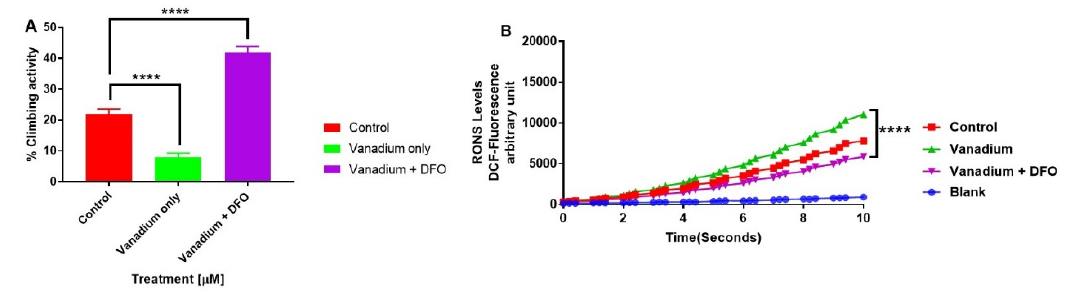
Figure 5. The influence of iron chelation following a chronic exposure of Drosophila melanogaster (PINK-1 mutant) to low-dose vanadium upon motor activity ( A ) and reactive oxygen species (ROS) production in fly brains ( B ) on day 14. Exposure of PINK-1 mutant to vanadium exacerbated the existing locomotor deficits in PINK-1 flies (**** p < 0.0001), comparing the slope of vanadium versus the control. However, a significant improvement was observed in the motor activity in the presence of the iron chelator (DFO) + vanadium (**** p < 0.0001), in comparison to vanadium alone. Results showed that the treatment with a low dose of vanadium enhanced ROS generation ( B ) after 14 days in PINK-1 mutant flies, when compared with the control group. In contrast, iron chelation (DFO) completely reversed the vanadium production of ROS ( B ), which is statistically significant (**** p < 0.0001) when compared with vanadium only. All values are means ± SD, from 5 separate replicates; n = 10 flies for each individual experiment; data were analysed with a repeated measure one-way ANOVA (with Tukey’s multiple comparisons test) (**** p < 0.0001).